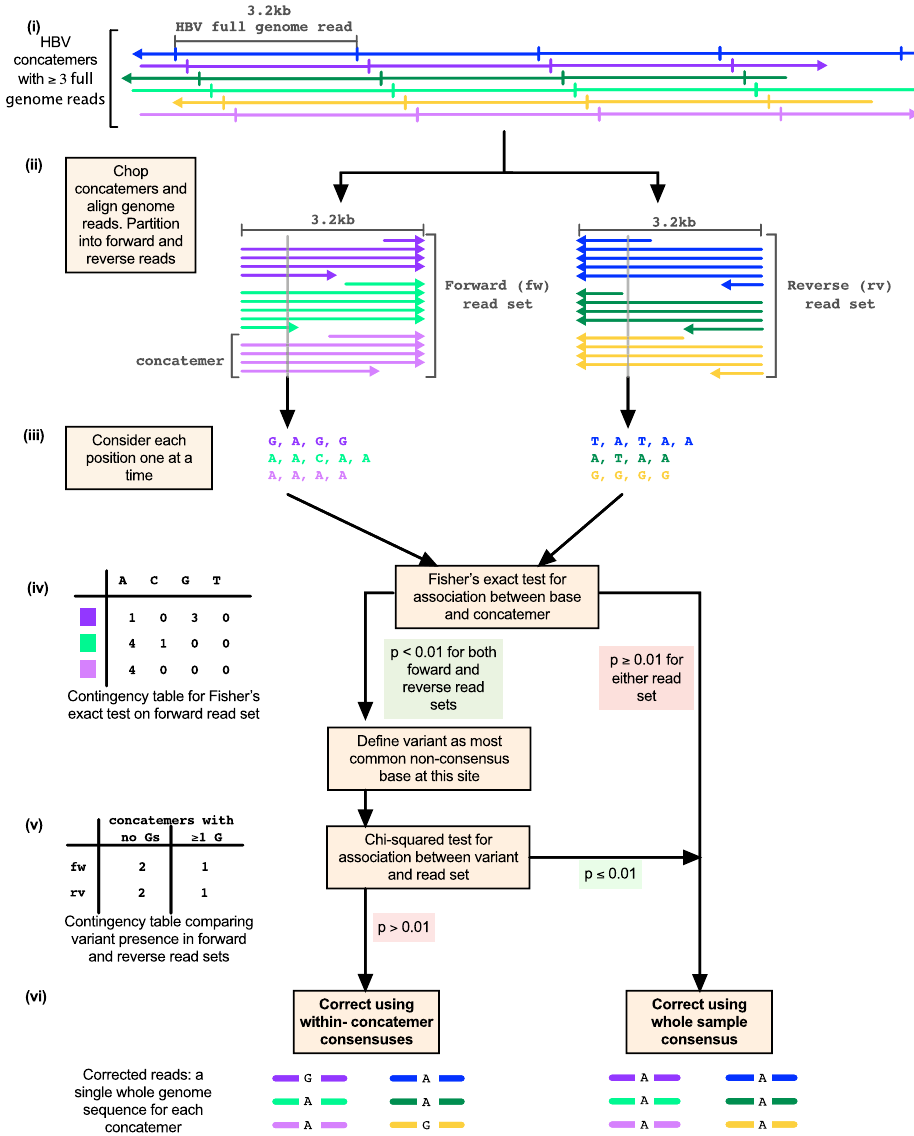
Figure 4. Error correction in Nanopore HBV sequence dataset. Schematic to depict the identification and removal of basecaller errors. (i) 6 concatemers containing at least three full length HBV reads (plus two partial genome reads) are illustrated. The same 6 colours are used throughout this figure to indicate the concatemer of origin. (ii) Concatemers are shown chopped into full and partial genome reads, partitioned according to whether they align to the forward (LHS) or reverse (RHS) strand of the reference. (iii) Each position is considered independently. Aligned bases for the position in question are collected and grouped by concatemer, as shown by the coloured list of bases. (iv) Fisher’s Exact test is conducted to determine the strength of association between base and concatemer within each read set. In the example contingency table on the left for the forward read set, guanine is found consistently in the dark purple concatemer but not in the other two concatemers. (v) The example contingency table illustrates conducting a Chi-squared test to see whether concatemers containing the variant, guanine, are significantly more common in one of the two read sets (forward or reverse). Significance criteria for the tests in (iv) and (v) are shown on the flow diagram, with significant results highlighted in green and non-significant results highlighted in red. (vi) The corrected concatemer sequence for this position of interest is illustrated, for the case where concatemers are corrected using the whole sample consensus base (right), and for the case where concatemers are corrected using the within-concatemer consensus base (left). Note that the p-values from step (iv) are also used to assign a quality score to each variant, as described in the methods and reported in Suppl Table